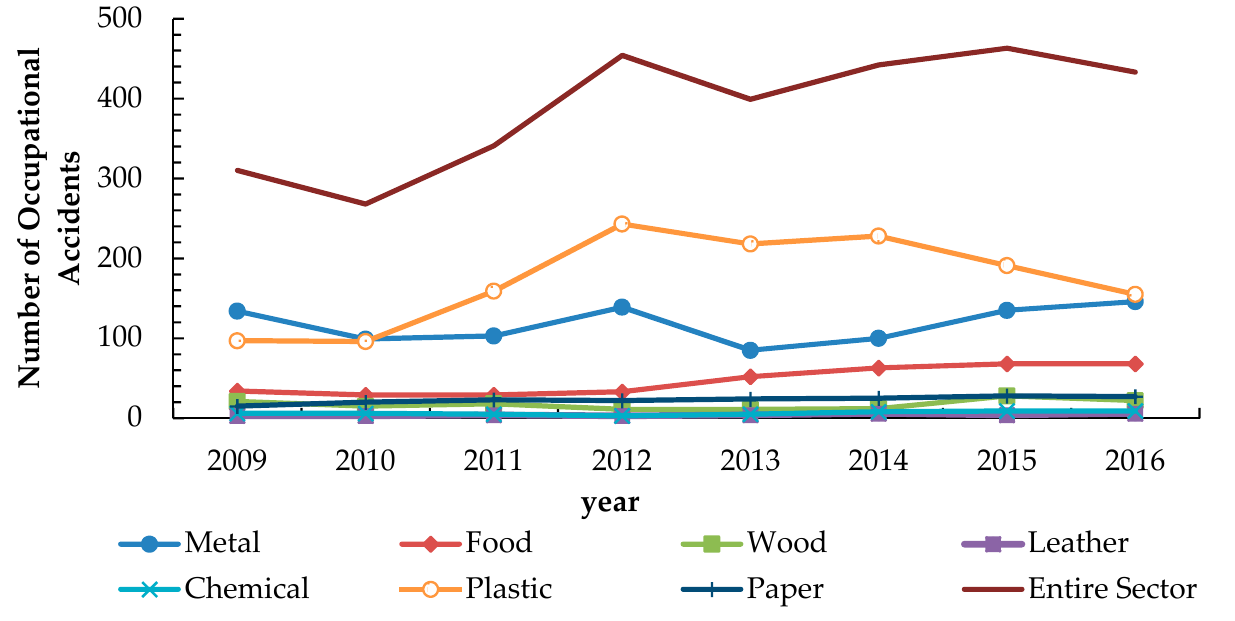
Figure 11. Occupational accidents in all Palestinian industrial sectors during 2009–2016. A summary of the OSH statistics and estimated financial losses of each industrial sector under study is shown in Table 6. Table 6. The OSH statistics of each industrial sector between the years 2009 and